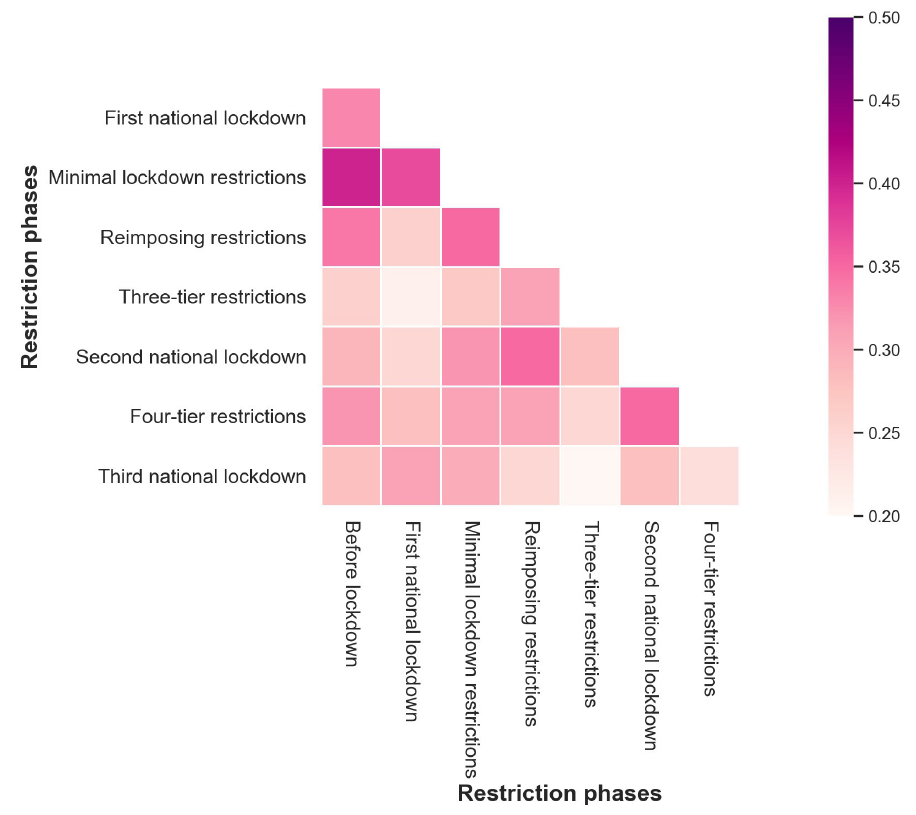
Fig 7. The difference between the HAZs from eight restriction